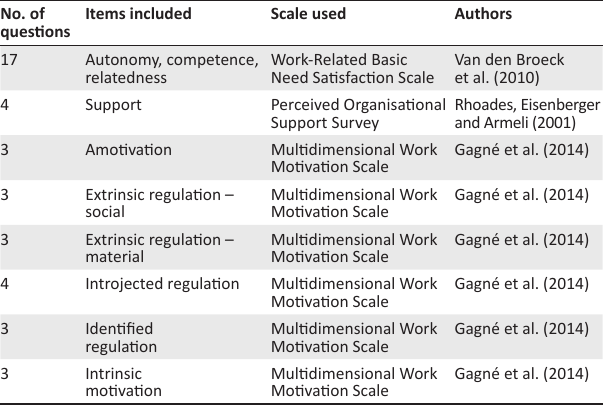
TABLE 1: Components addressed in part 2 of the